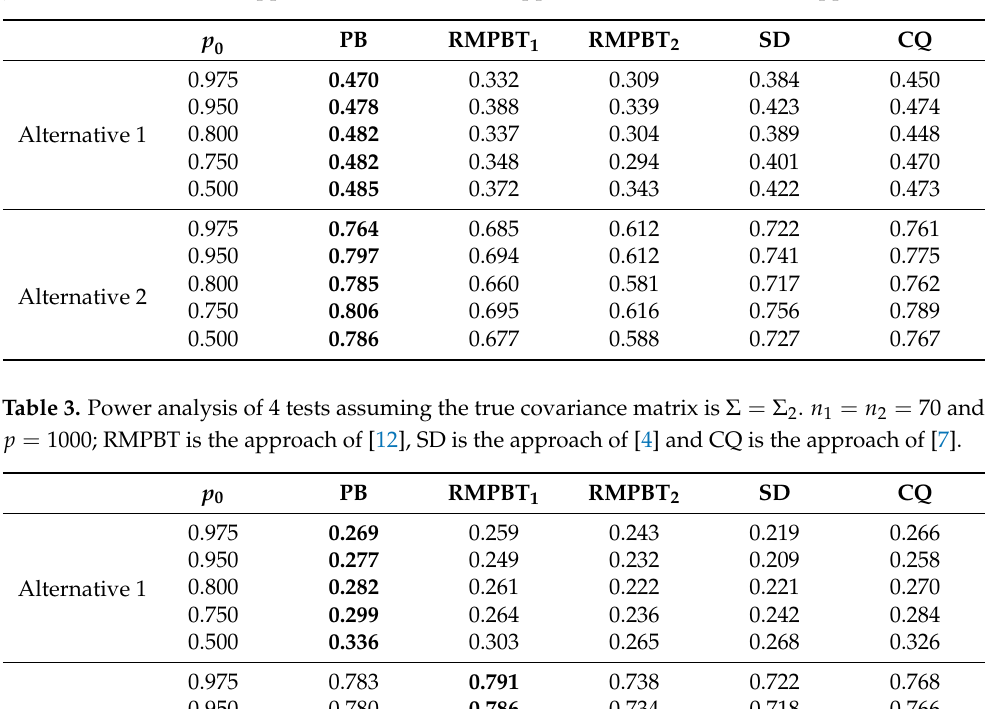
Table 2. Power analysis of 4 tests assuming the true covariance matrix is Σ = Σ 1 ; n 1 = n 2 = 70 and p = 1000. RMPBT is the approach of [12], SD is the approach of [4] and CQ is the approach of [7].